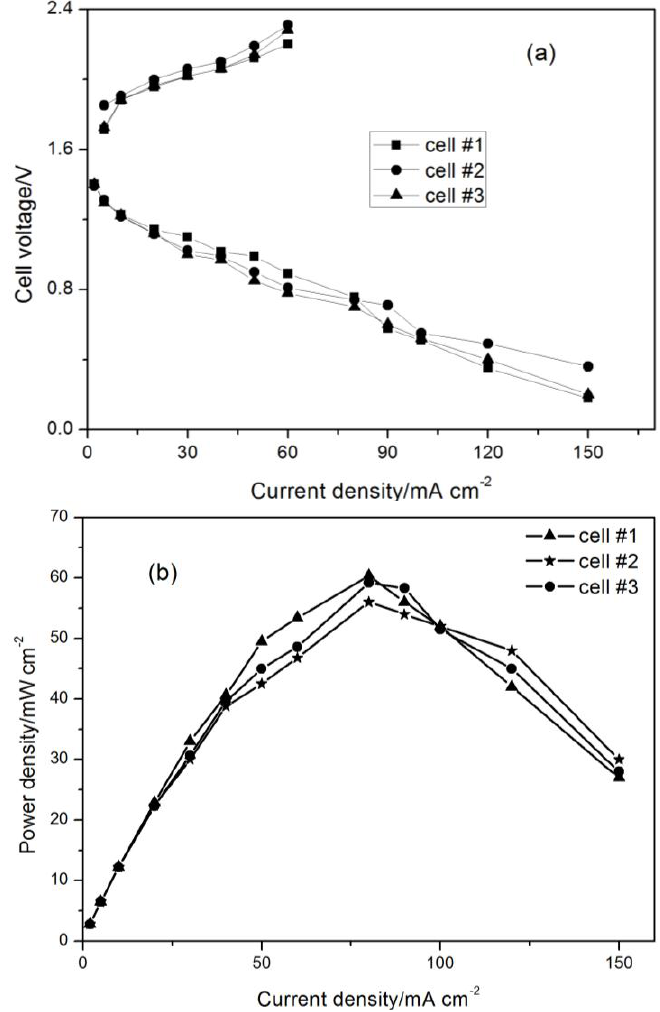
Figure 2. ( a ) Anodic and cathodic polarization characteristics for each single cell in the three-cell zinc air battery stack; ( b ) power density performance for each single cell in the